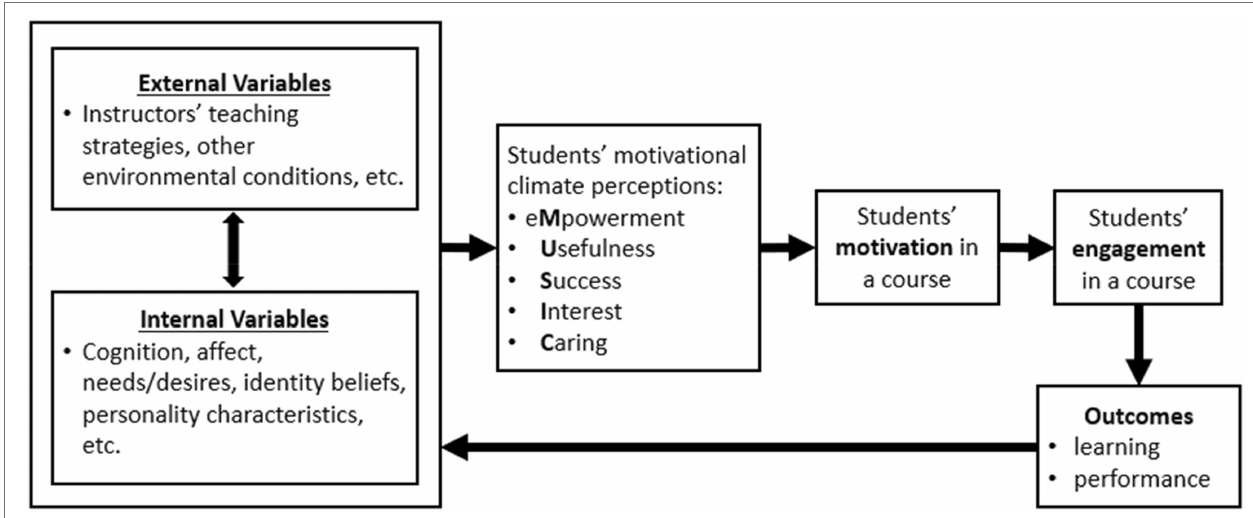
FIGURE 1 | Key elements of the MUSIC model of motivation. Adapted from “Motivating Students by Design: Practical Strategies for Professors” by Jones (2018). Used with